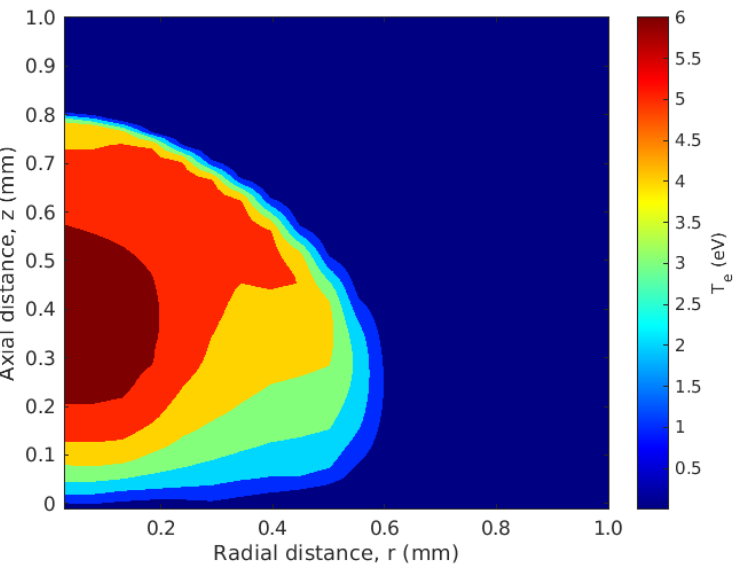
Figure 2. Results of the laser ablation simulation showing the distribution of the electron temperature in an ablated titanium plasma plume calculated at 5 ns after the laser pulse. The laser fluence was 100.5 J cm − 2 and the laser focus was 100 µ